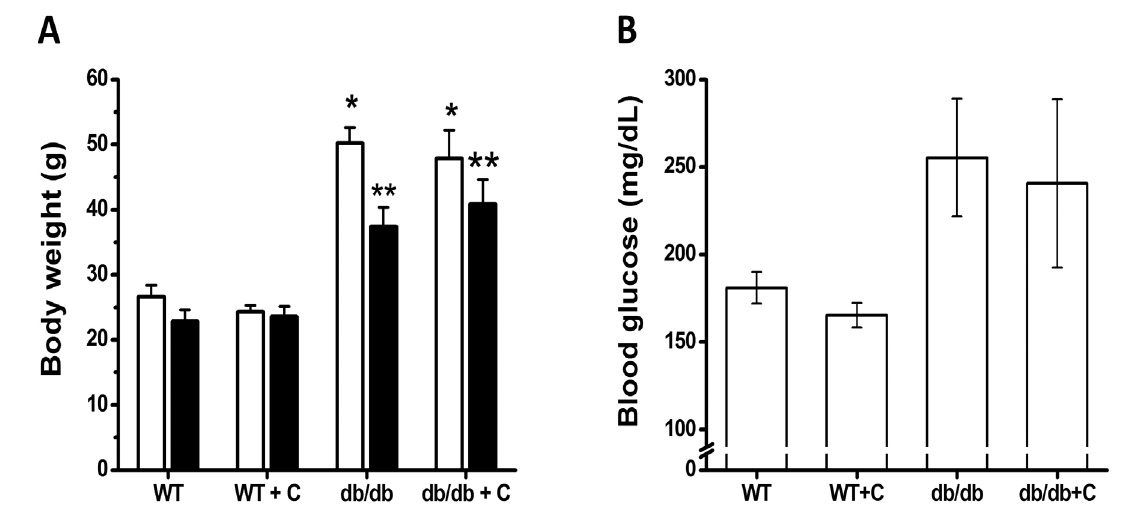
Figure 1. Effects of curcumin on body weight and blood glucose levels of mice. ( A ) Body weight: The body weight of mice was measured at the beginning and end of curcumin treatment. ( B ) Blood glucose levels: The levels of glucose were determined at the end of curcumin treatment. □ , initial weight. ■ , final weight. Data are the means of n = 3 ± SEM. * vs. WT and WT+C (initial), p < 0.001; ** vs. WT and WT+C (final), p <